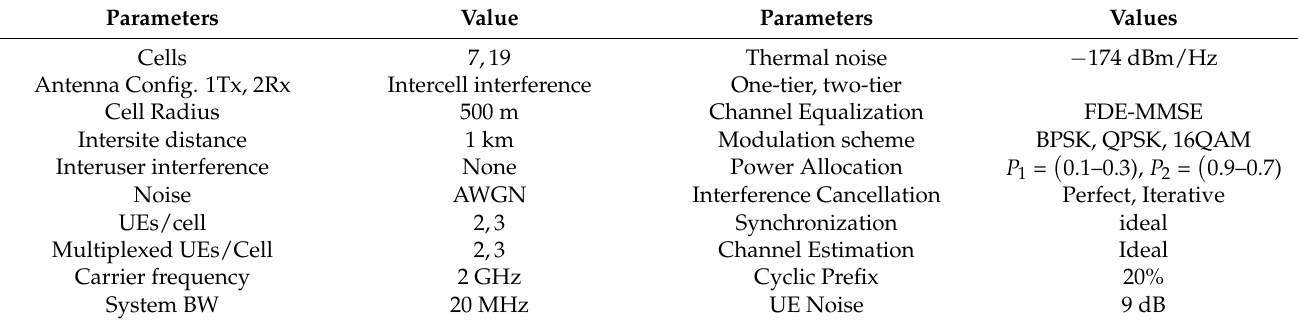
Table 1. Link-level and system-level parameters for exemplary